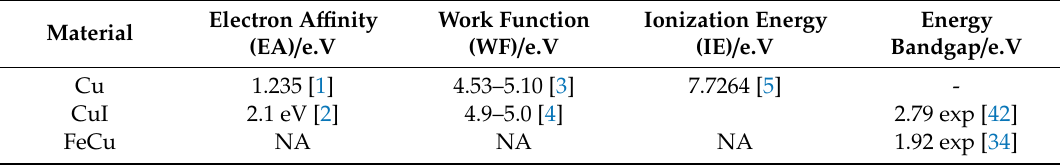
Table 1. Electronic and energy quantities for the produced